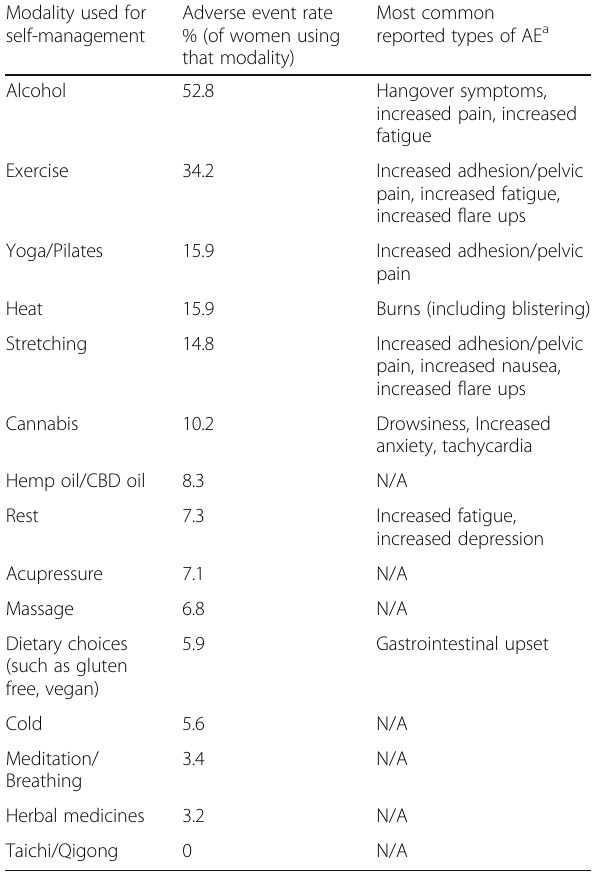
Table 4 Adverse events from self-management modalities, listed from most to least commonly